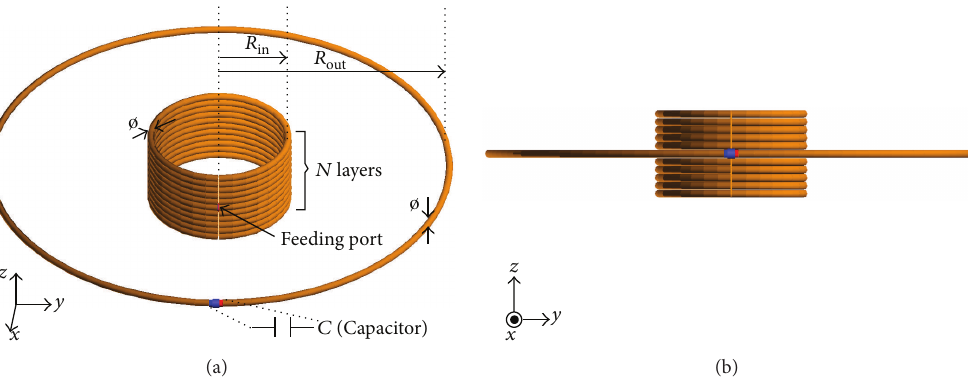
Figure 1: Antenna geometry and detailed specification of each design variable. (a) 3D view and (b) 2D lateral